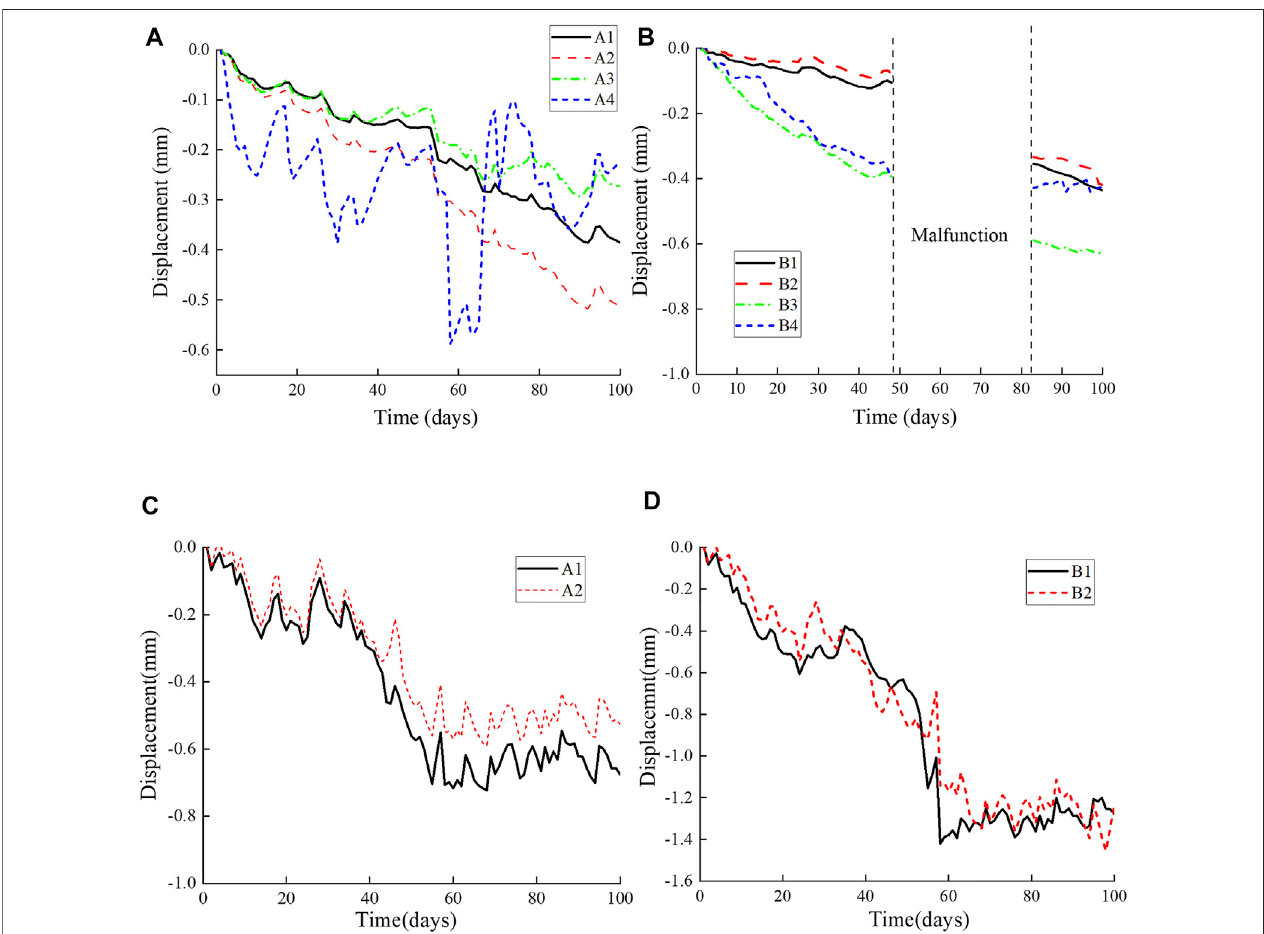
FIGURE4| Variation characteristics ofstresswithtime ateach measuringpoint of (A) holeAand (B) holeBand displacement withtimeat eachmeasuringpointof (C) hole A and (D) hole (B).